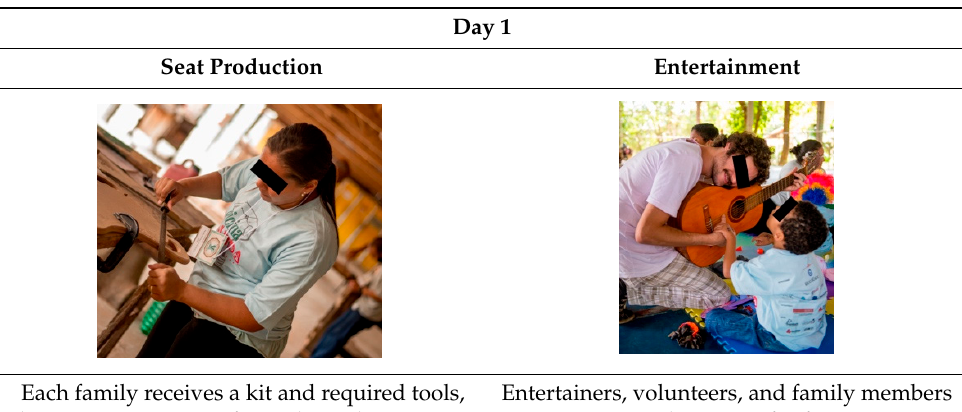
Table 2. The second day of the Ciranda Workshop event.